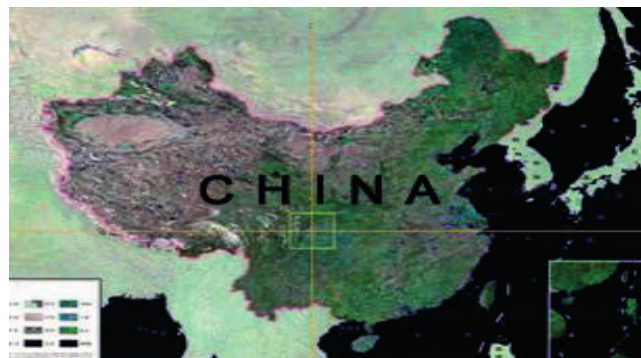
Fig. 2 Geographical location of Chengdu.